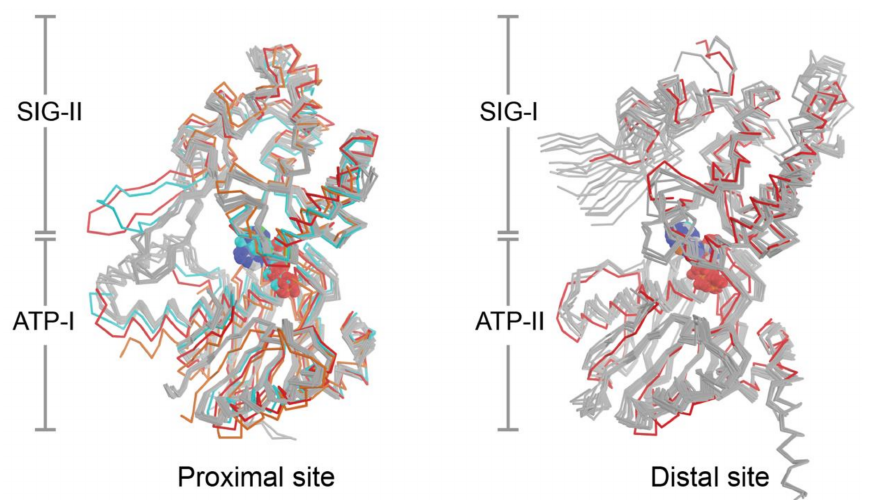
Figure 4. The proximal and distal nucleotide binding sites of UvrA. The nucleotide-binding domains that make up the proximal and distal nucleotide-binding sites from Protein Data Bank (PDB) entries 2R6F [37], 3UX8 [21], 3UWX [21], 3PIH [19], 3ZQJ [45], 2VF7 [44], 2VF8 [44] and 6N9L [46] were superimposed on the ATP-binding (ATP) domain. The structures are colored in gray save for 3UX8 (orange), 3PIH (red) and 6N9L (cyan) in the proximal site alignment; and 3PIH (red) in the distal site alignment. The colored structures deviate from remaining members of the group by rotation of their respective signature (SIG)